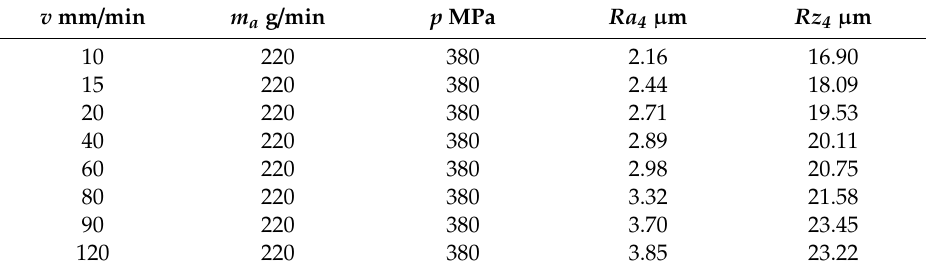
Table 5. Typical series of roughness values Ra 4 , Rz 4 (abrasive mass flow rate 220 g / min and pressure 380 MPa are typical technological parameters used for cutting).